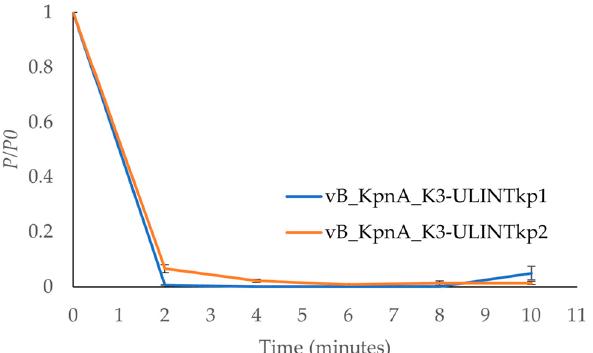
Figure 5. Adsorption time of the bacteriophages vB_KpnP_K3-ULINTkp1 (blue curve) and vB_KpnP_K3-ULINTkp2 (orange curve). P 0, initial bacteriophage concentration; P , number of free bacteriophages.